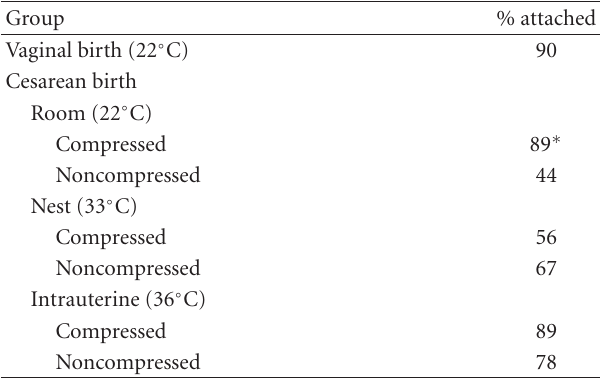
Table 1: Percentage of newborn pups attaching to nipples of anesthetized dams ( N = 9 per condition). ∗ P <